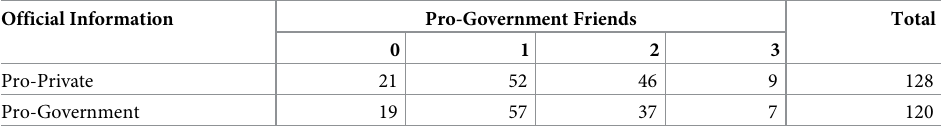
Table 1. Number of participants with complete longitudinal data (including friend data) in each cross-classifica- tion defined by the official information assignment and their friends’